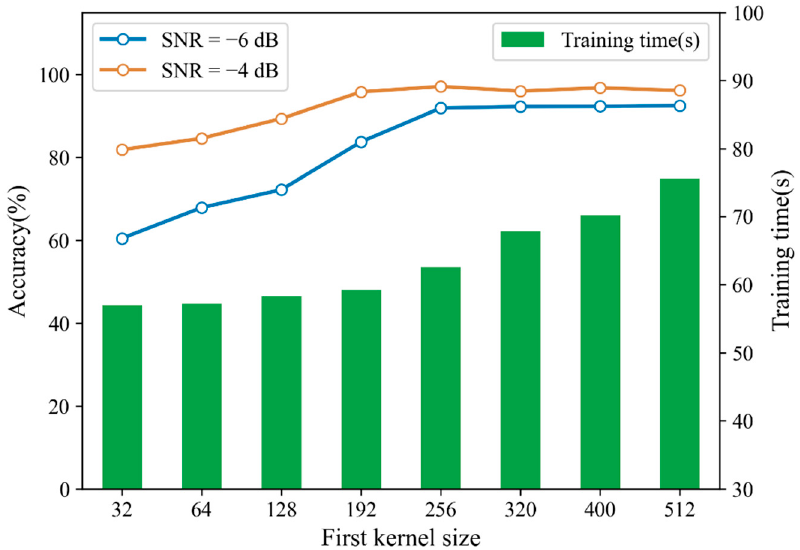
Figure 11. Diagnosis accuracy and training time under different sizes of first-layer convolution ker-